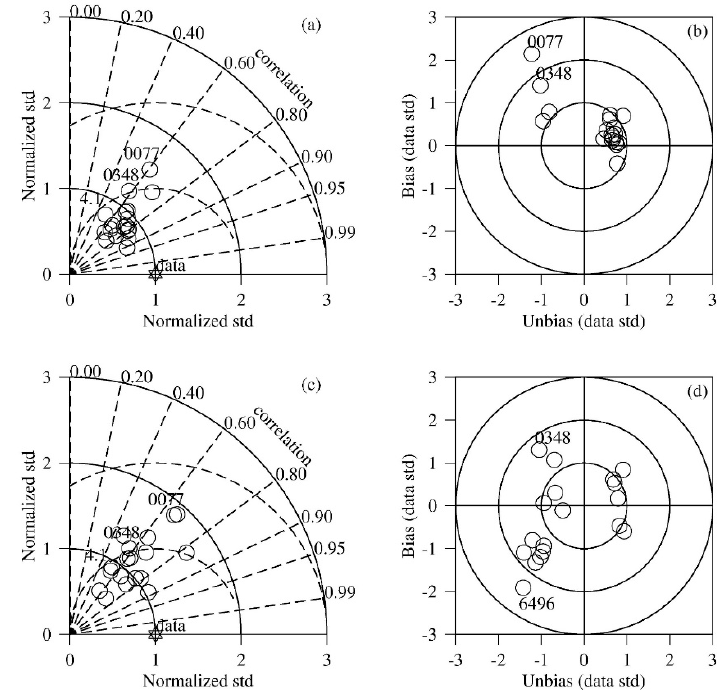
Figure 4. Taylor and Target diagrams of surface ( a and b ) and bottom ( c and d ) DO at all 25 stations. Stars in the Taylor Diagram represents the observation and the standard deviation of simulation are normalized to the standard deviation of observation. Bias and unbias between the observation and simulation are also normalized in the Target Diagram.